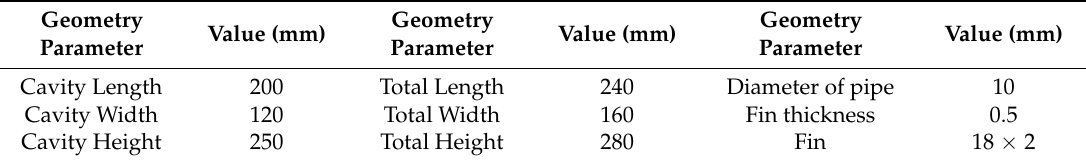
Figure 3. ( a ) Designed structure of the external part; and, ( b ) Experimental structure of the external part. Table 1. Geometrical parameter of the heater.